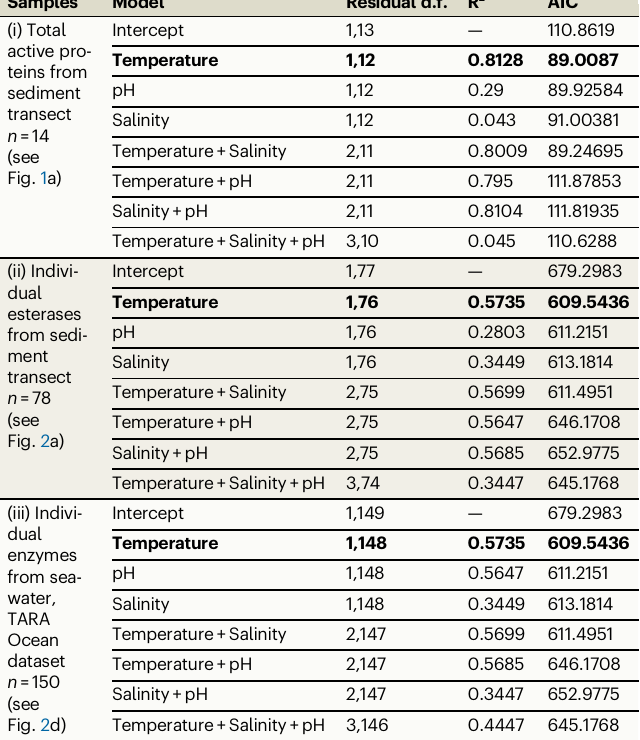
Theresidualdegreesoffreedom(d.f.)aregiven.Thetreatmentdegreesoffreedomandsumof squares only applytotheterm that was added to themodel. TheAkaike informationcriterion (AIC) was calculated foreachmodel and thelowestAIC(in bold) indicatesthebestmodel